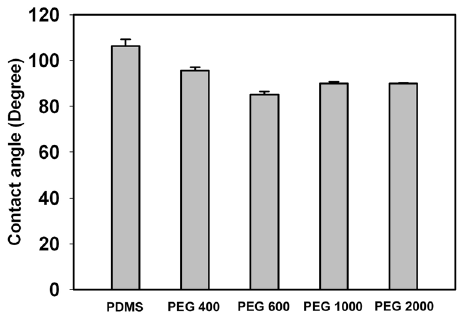
Fig. 4 Water contact angles of PDMS and PDMS-PEG-PLL with PEG at various molecular weights. Data are exhibited by mean ± SEM ( n =